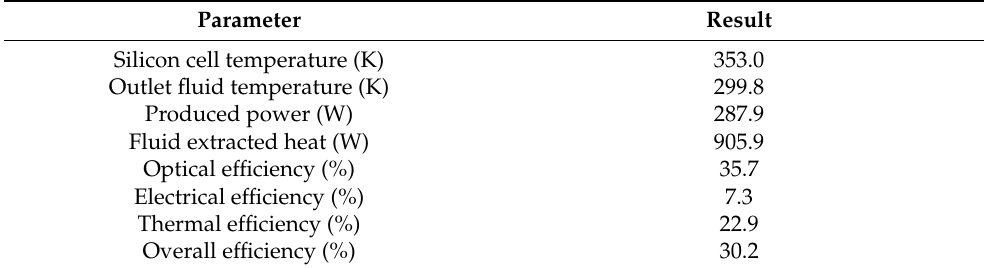
Table 5. Thermal and electrical production of the linear Cassegrain-type CPV/T solar collector,